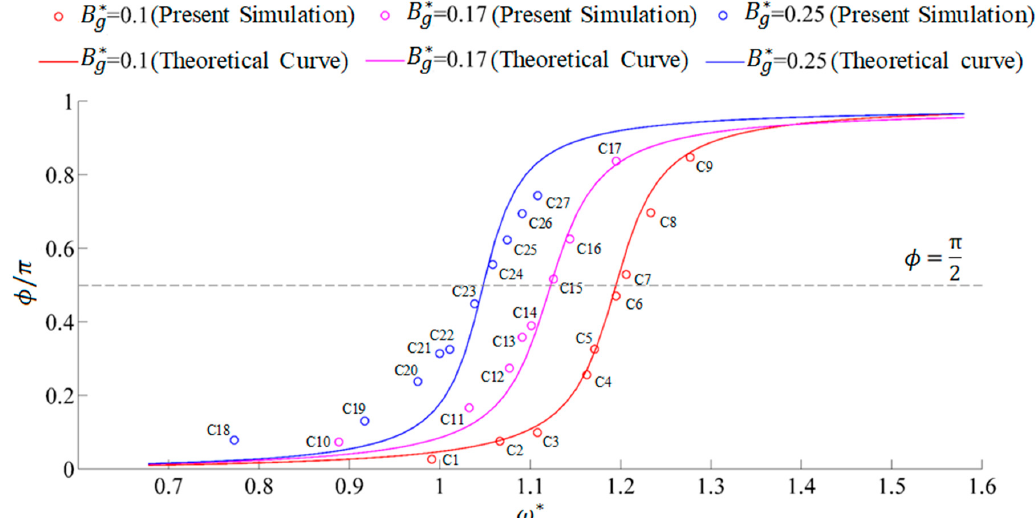
Figure 20 . The dimensionless phase retardation ( 𝜙/𝜋 ) of the elevation inside the gap relative to the wave phase in front of SQ1 of the present numerical simulations (evaluated based on Equation (24)) and the theoretical estimation based on Equation (26a–c).